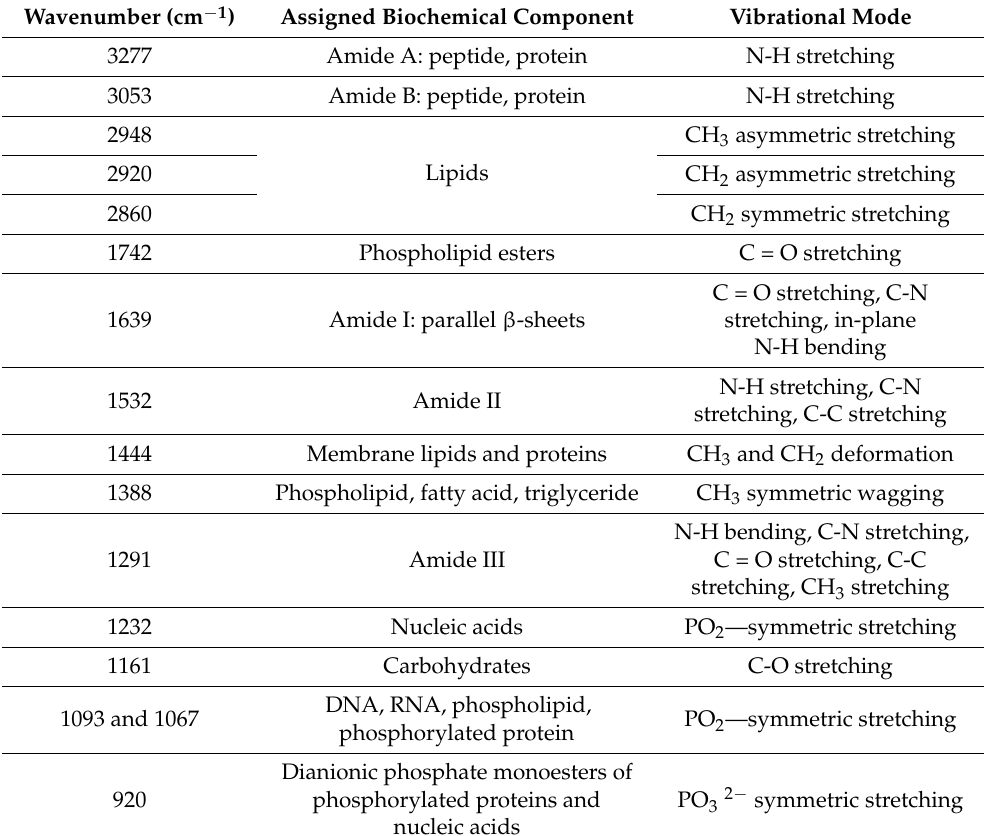
Table 2. Spectral peaks and the corresponding biochemical components and vibrational modes of a typical normal thyroid cytological sample obtained by FNA. Adapted from